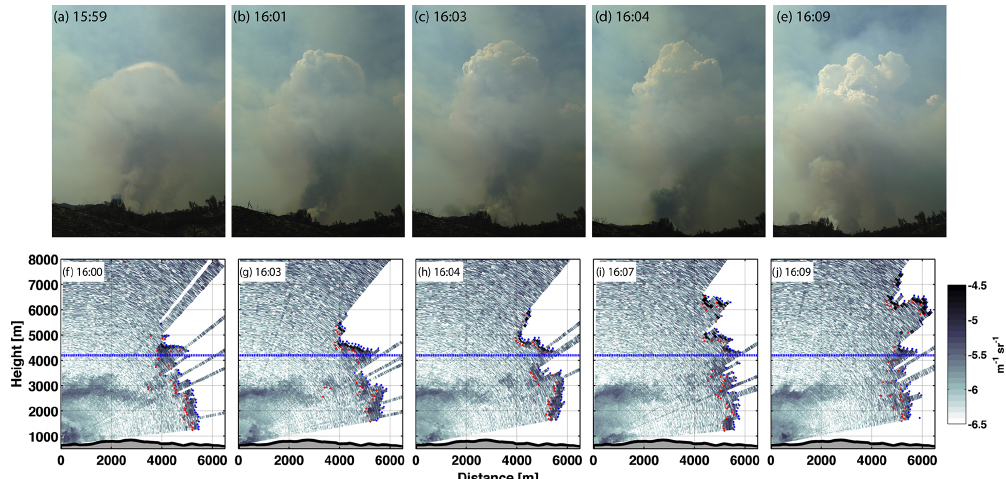
Figure 12. Pyrocumulus development from 15:59–16:09PDT on 30 July 2015. (a–e) Photographs of the plume rise and pyroCu development. (f–j) Lidar backscatter showing the onset of condensation and subsequent cloud growth. The dashed blue lines shows the lidar-derived condensation level.